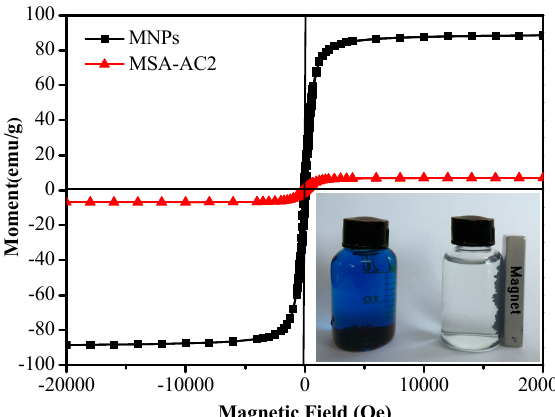
Figure 5. The field-dependent magnetization curve of MNPs (Fe 3 O 4 ) and MSA-AC2 at room temperature and a photo of magnetic separation.